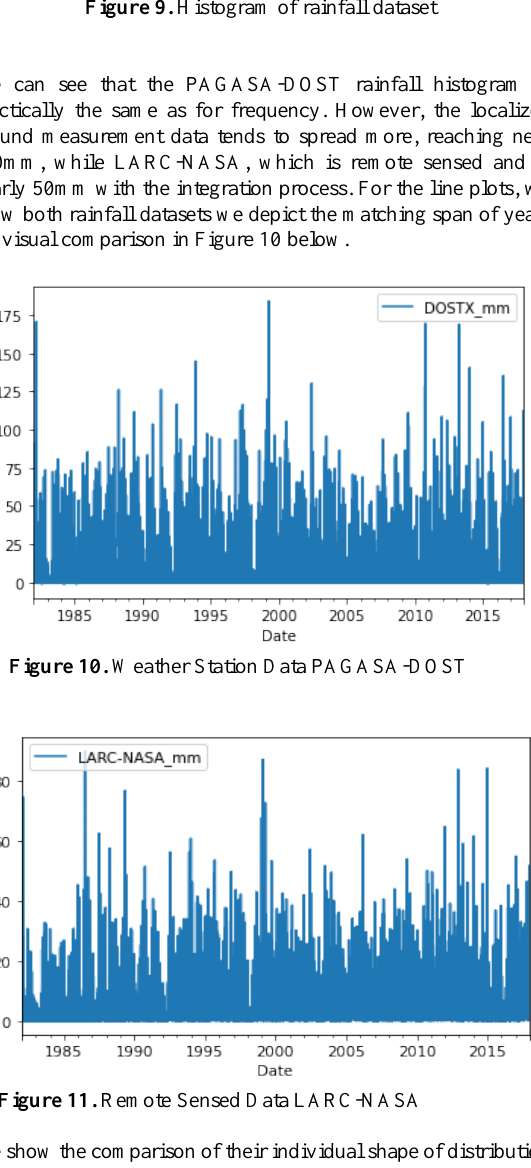
Figure 9. Histogram of rainfall dataset